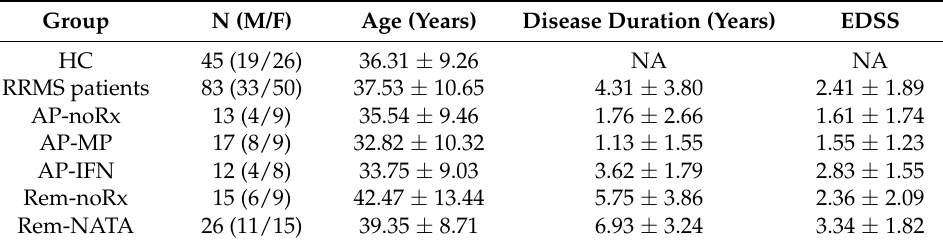
Table 1. Demographic and clinical characteristics of MS patients and